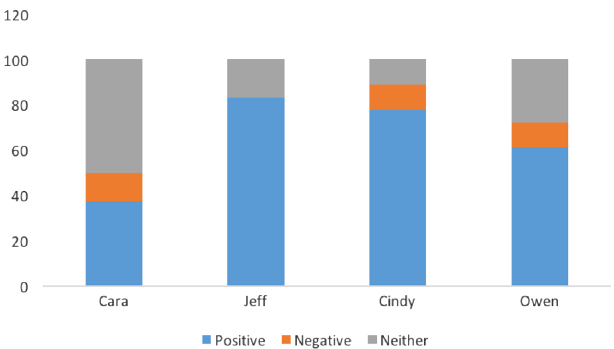
FIG. 7. The percentage of positive, negative, and neither material resource codes per participant. Each percentage is normalized to the total number of material resources that were coded in each participant ’ s